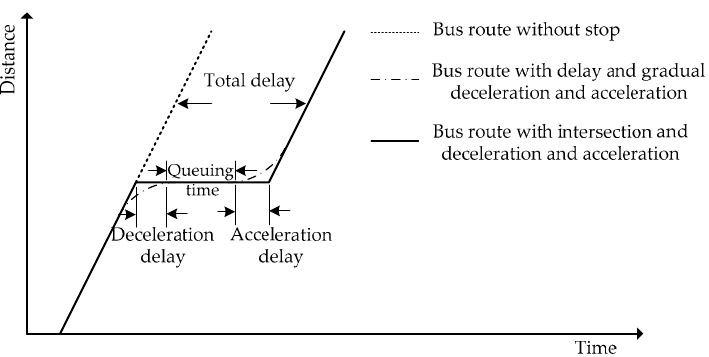
Figure 2. An intersection of queuing time for Figure 2 . An intersection of queuing time for FBS.